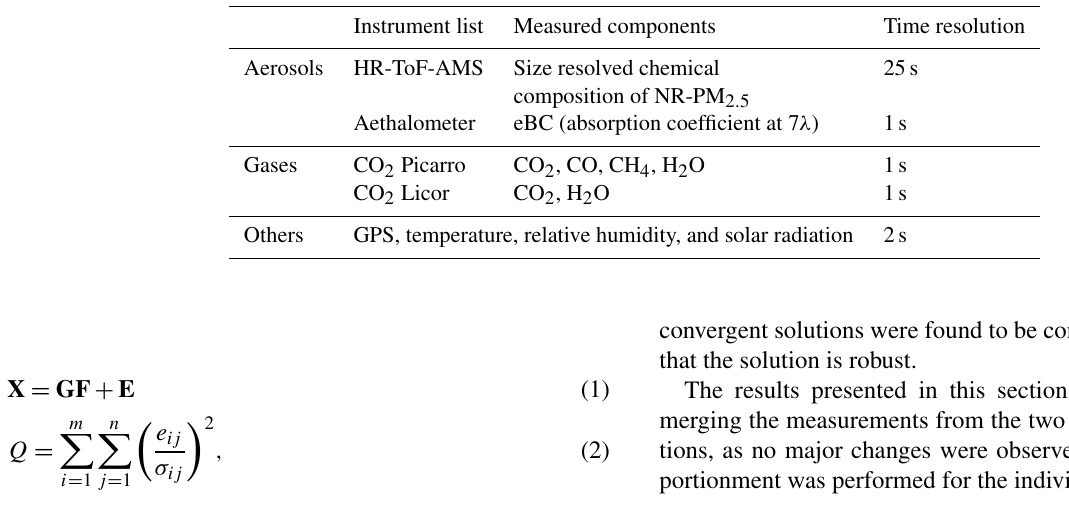
Table 1. Instrument list, measured components, and time resolution of each